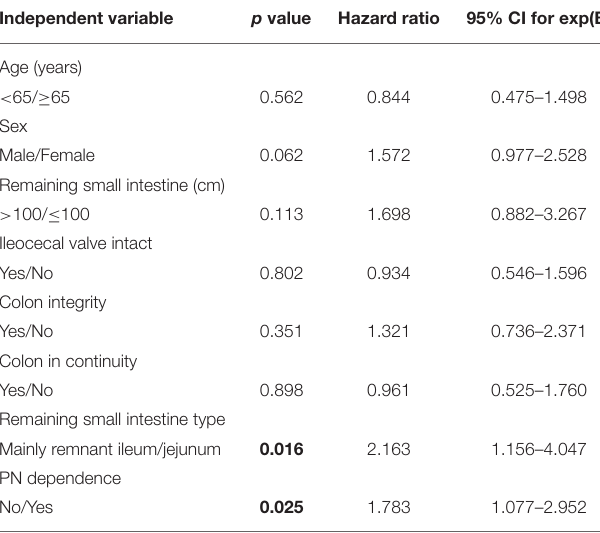
TABLE 4 | The Cox proportional hazard model analysis of the independent variables associated with cholelithiasis in adult with SBS. Independent